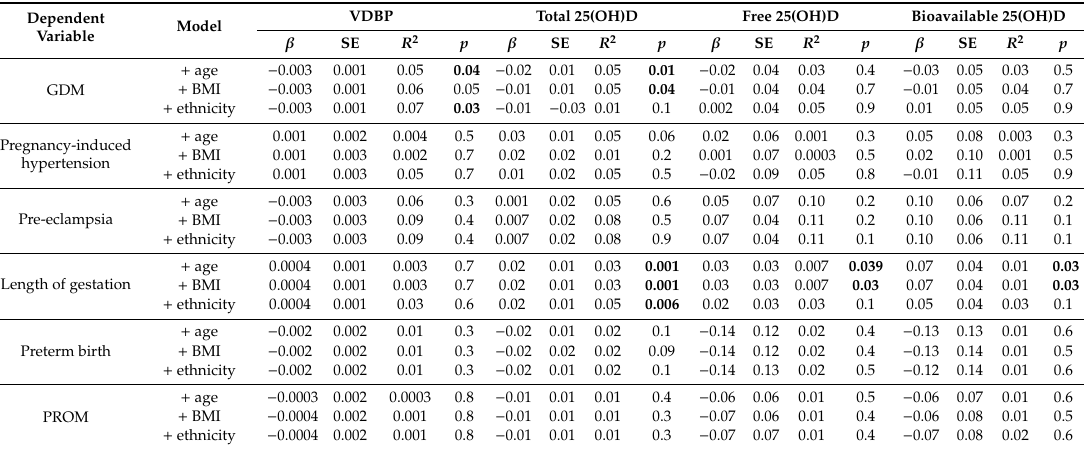
Table 6. Multivariable regression analyses of the relationships between vitamin D metabolites and the pregnancy outcomes after adjustment for maternal